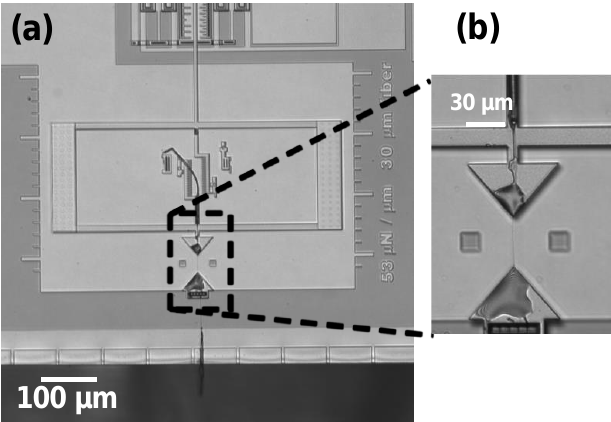
Figure 7. Optical image of UHWMPE nanofiber tor ready for mechanical testing. ( a ) The fiber is glued to both grips pads after the cutting process ( b ) Magnified image of the pads after gluing.